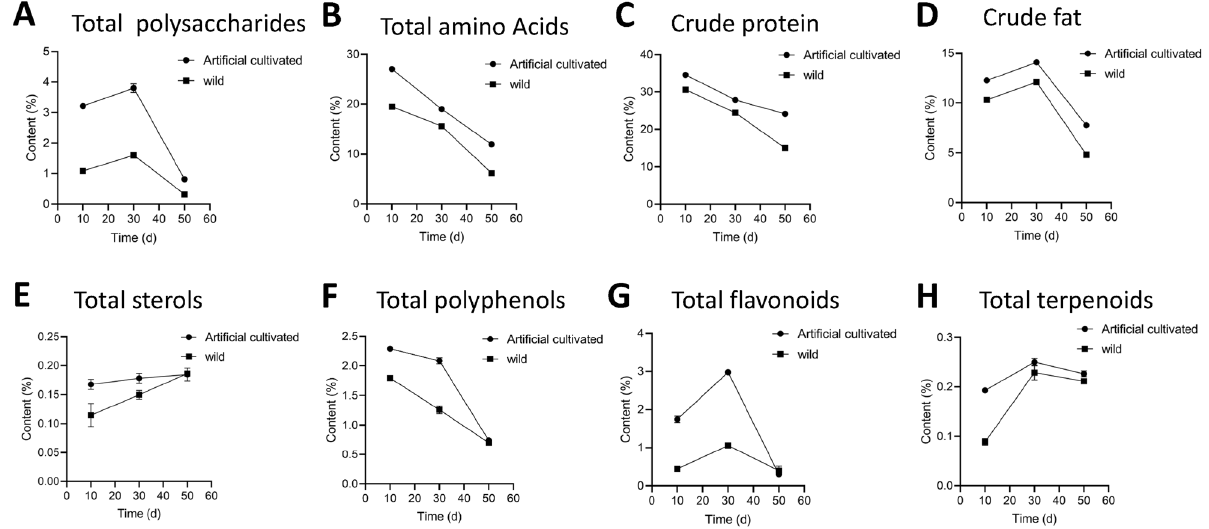
Figure 4. Line diagram of content changes of total polysaccharides, total amino acids, total proteins, crude fats, total steroids, total polyphenols, total flavonoids, and total terpenoids in Inonotus